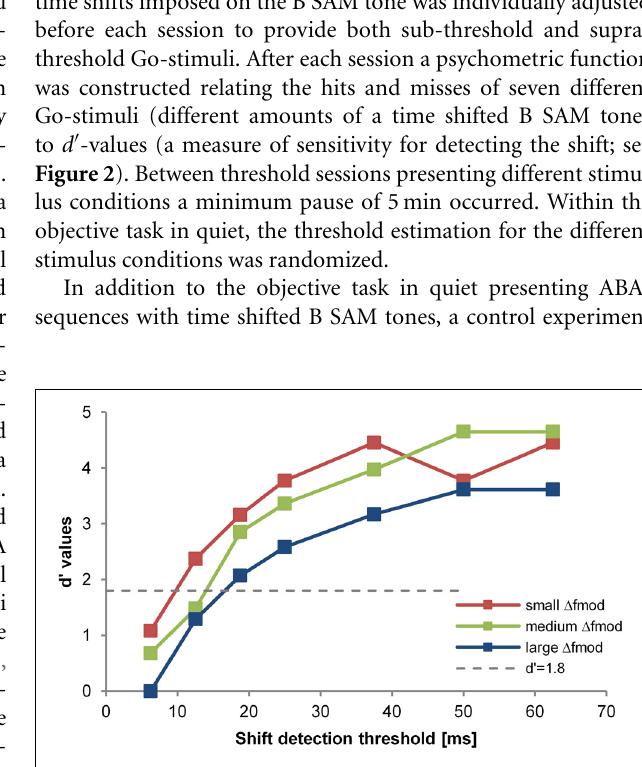
tones had the same carrier frequency ( f c ) but different modulation frequencies ( f mod ). The f mod of the B SAM tone was always larger than the f mod of the A SAM tone ( f mod A ). Here the f mod difference between A and B SAM tones ( (cid:2) f mod ) is schematically shown (see Table 1 for exact values). Bottom: Schematic spectral view of the SAM ABA-